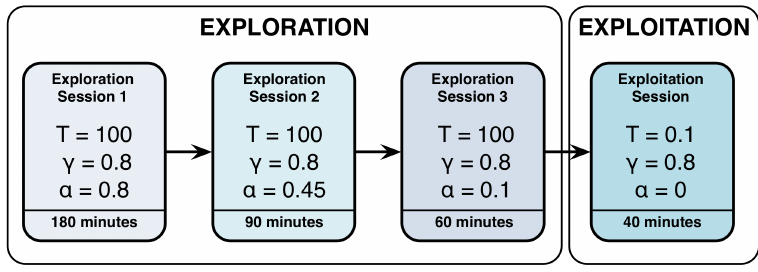
Figure 7. Phases of the experiment where the DMS has been